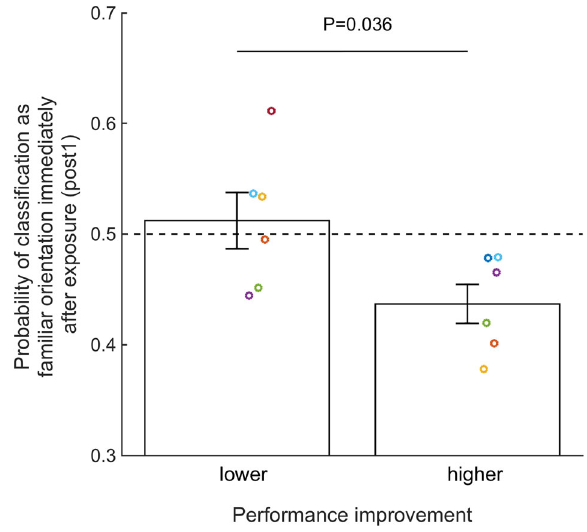
Fig. 4 Stronger awake suppression in subjects who exhibited greater learning. Awake suppression was quanti fi ed as brain activity after exposure to the familiar orientation that is less likely to be classi fi ed as the familiar orientation across V1 – V3 during the post1 scan. The awake suppression was signi fi cantly stronger for those subjects who showed greater learning on the trained orientation based on a median split. Error bars indicate s.e.m. Dots represent individual data. N =